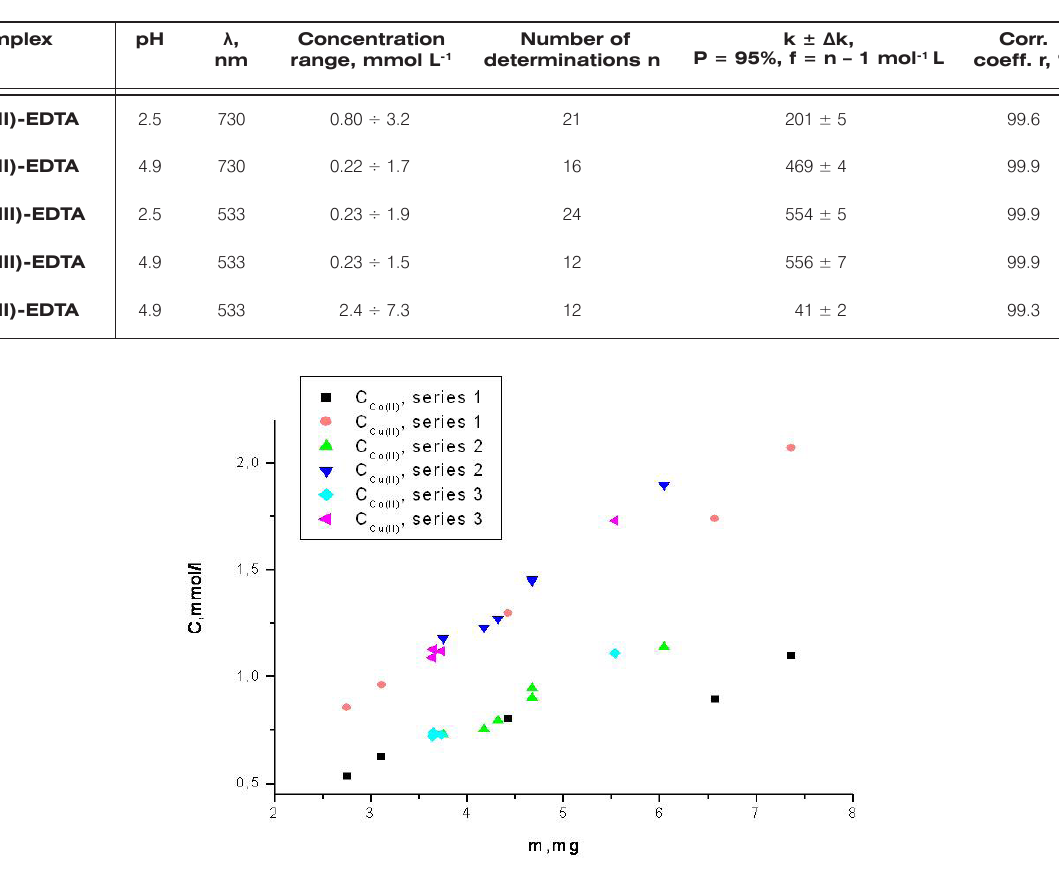
Figure 2. Influence of CoCl and EDTA on Co(III)-EDTA and Cu(II)-EDTA concentrations in the presence of 10 mmol KCl and 0.05 mmol HCl. The 2 quantities of CoCl